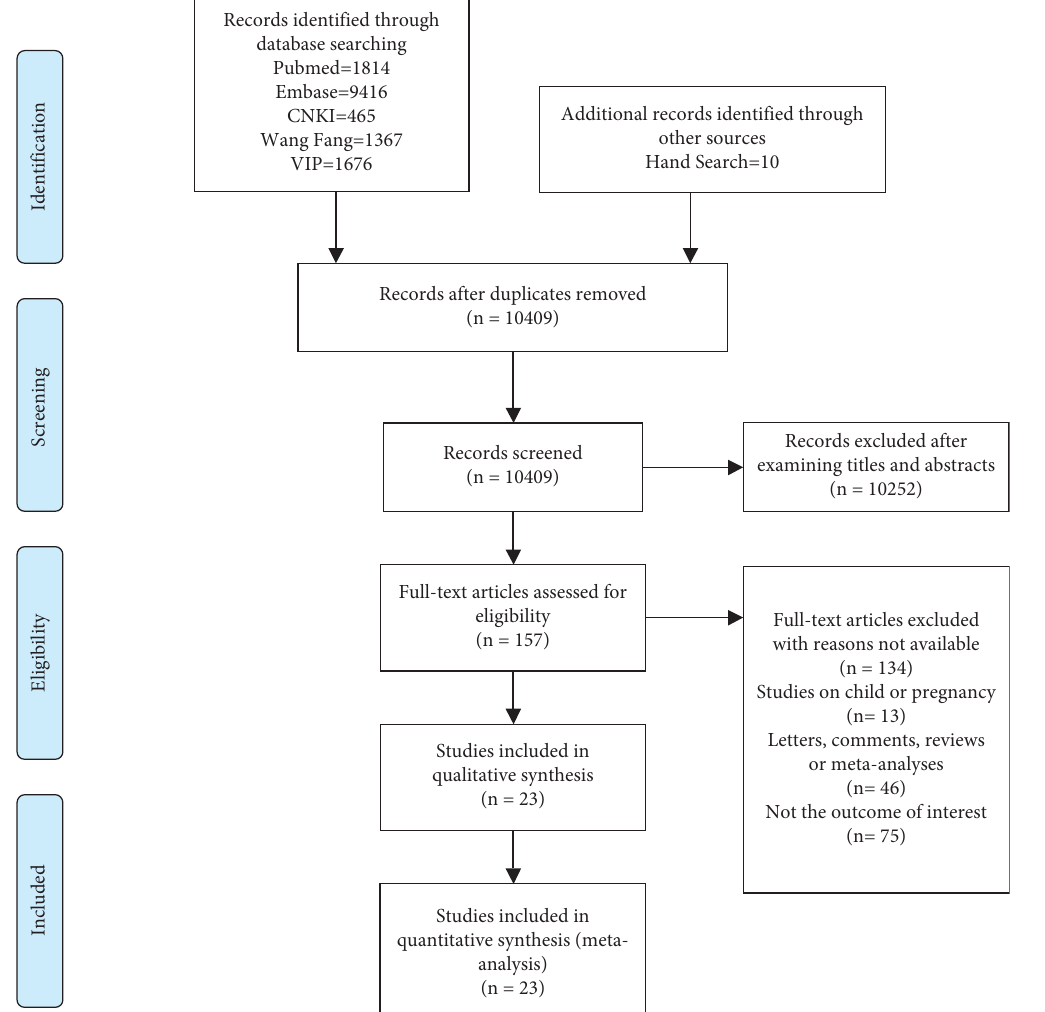
Figure 1: Flowchart of the article selection